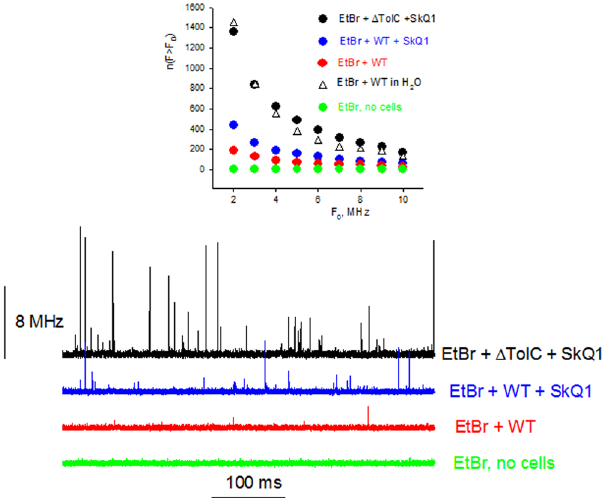
Figure 4. Effect of SkQ1 (10 µ M) on the accumulation of ethidium bromide by E. coli WT and Δ tolC cells, monitored by FCS. Fluorescence intensity traces of ethidium (10 nM) were recorded with the FCS set-up in the presence or absence of bacterial cells (10 6 per ml of PBS). Insert: Corresponding dependences of the number of peaks with the fluorescence intensity F exceeding the threshold F 0 , n(F > F 0 ), on the value of F 0